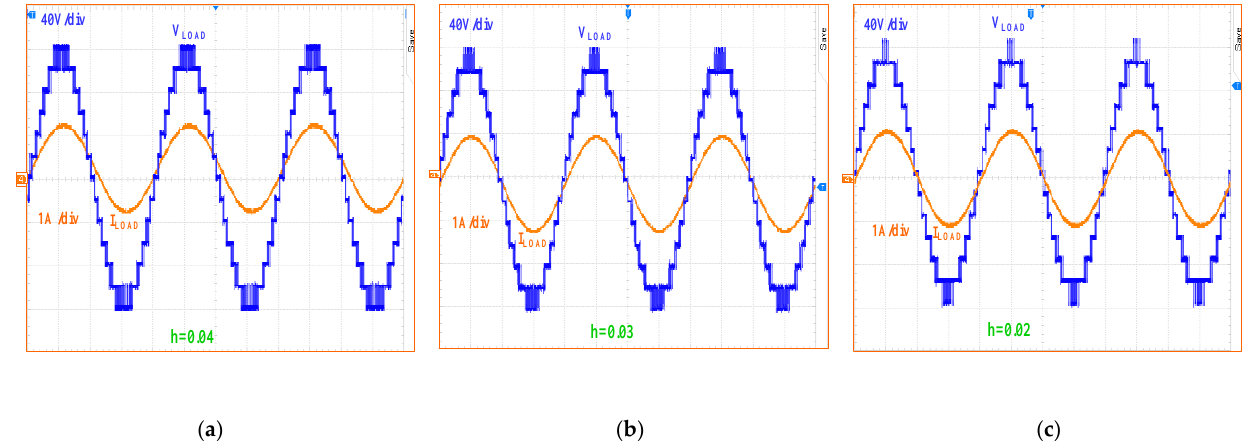
Figure 14. Output voltage and current waveforms at different bandwidth ( h ): ( a ) h = 0.04, ( b ) h = 0.03 and ( c ) h = 0.02.